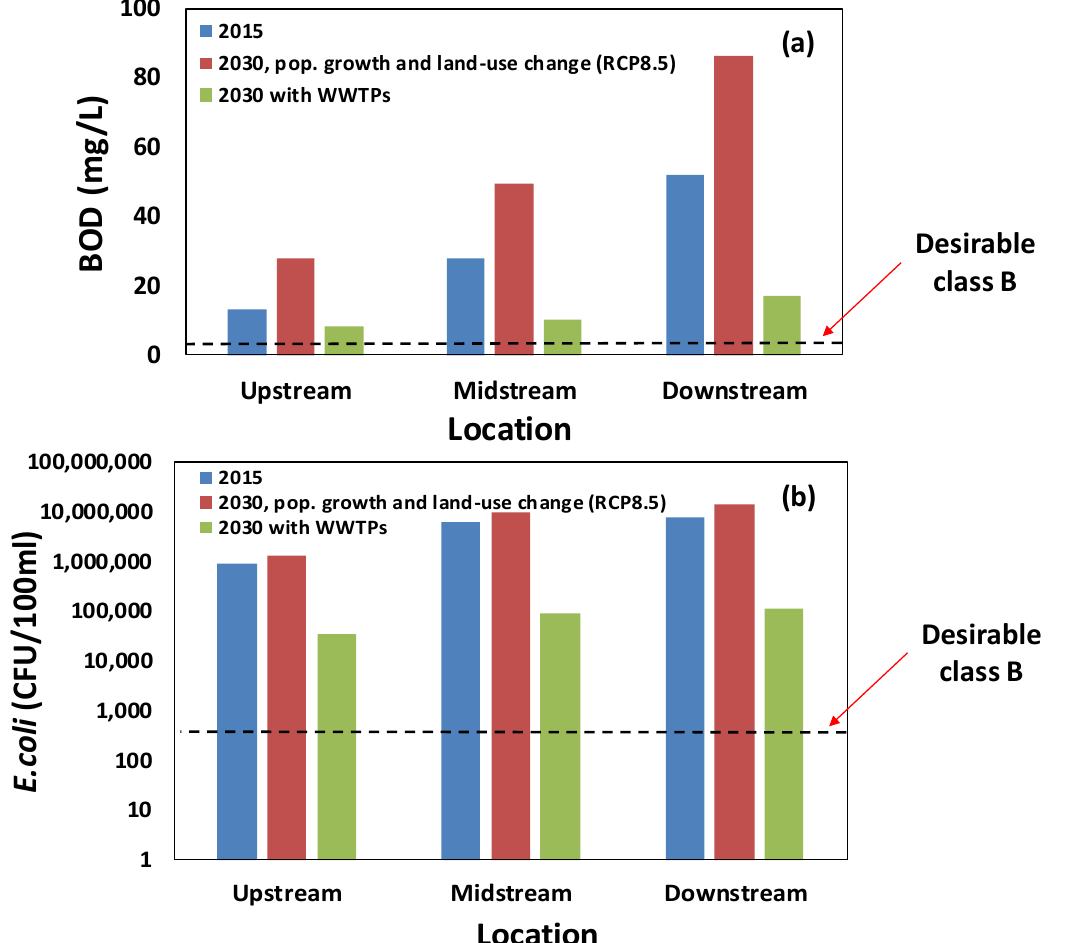
Figure 9. Result shows simulated water quality parameters ( a ) BOD ( b ) E. coli for scenario with adaptation measures.